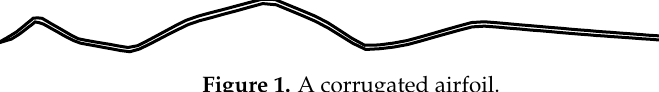
Figure 1. A corrugated